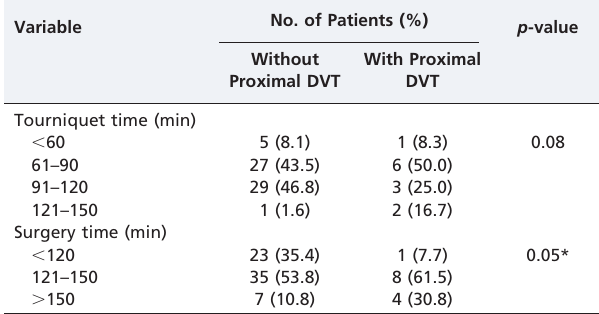
Table 2 - The population distribution based on tourniquet (n =74) and operative times (n= 78) and a comparative analysis of patients with and without DVT.